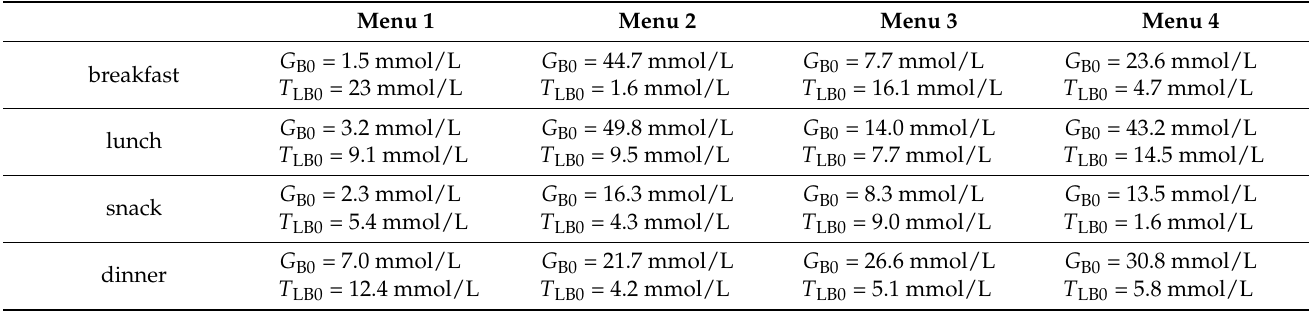
Table 4. Initial concentrations for the hepatic lipid metabolism model simulation based on developed menus.